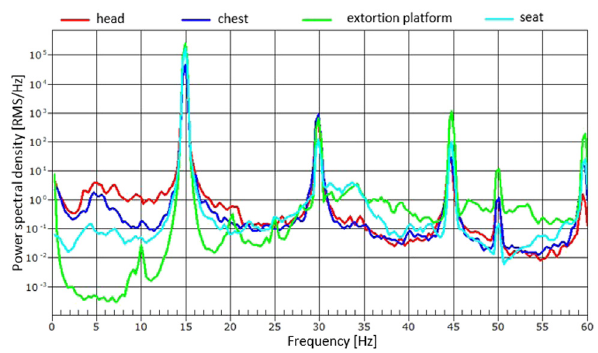
Figure 11: PSD for the excitation 15 Hz for the vertical direction.